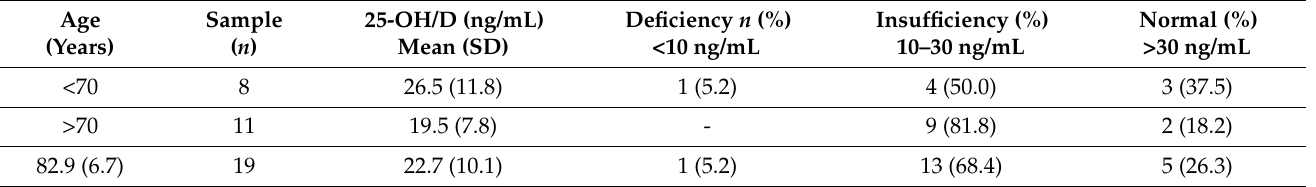
Table 2. Percentages of 25-hydroxy vitamin D characterized by ranges of deficiency, insufficiency, and